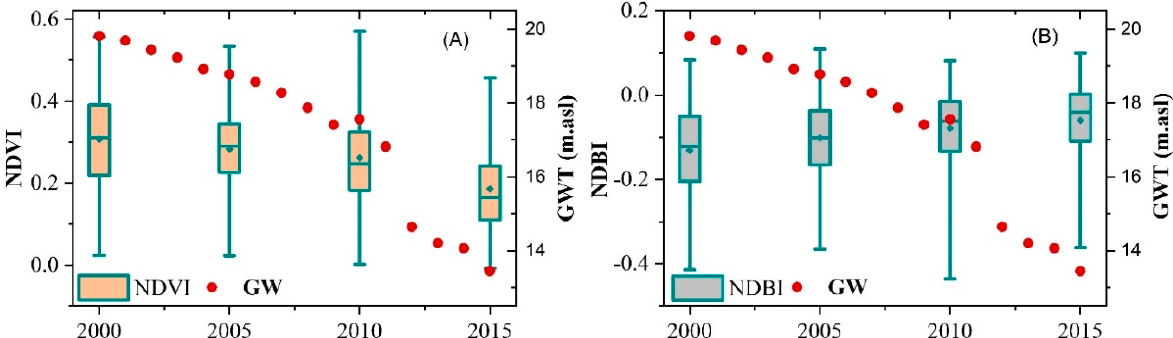
Figure 4. Spatial trend analysis of decreasing groundwater (GW) with NDVI ( A ) and NDBI ( B ) over the year 2000, 2005, 2010, and 2015. The whiskers represent the maximum and minimum values of both NDVI and NDBI, and the blue dots are showing the mean values respectively.